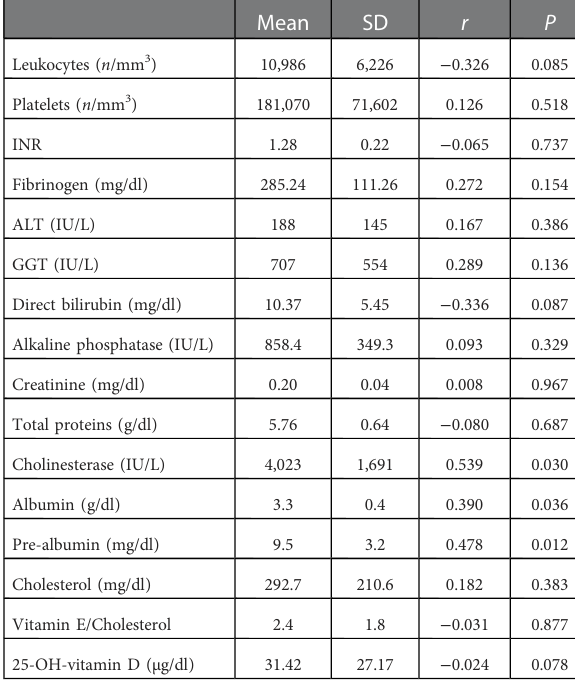
TABLE 2 Correlation of PMI with biochemical parameters before liver